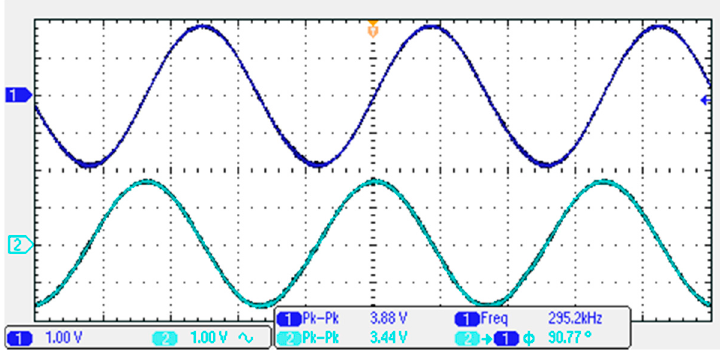
Figure 15. The experimental waveforms of the quadrature outputs V o 1 (channel 1) and V o 2 (channel 2). Appl. Sci. 2016 , 6 , 179